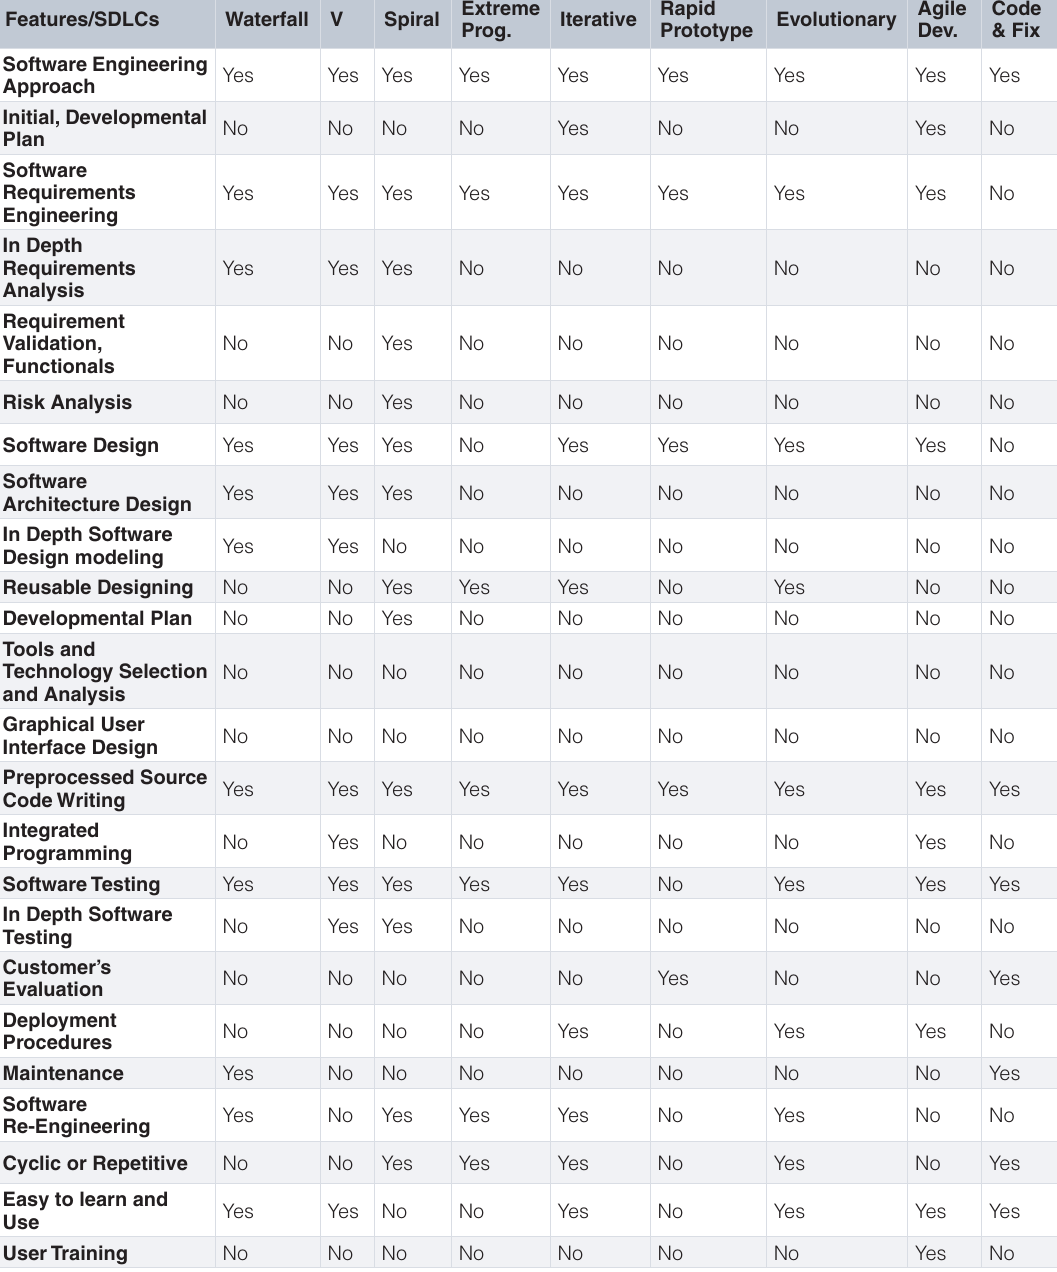
Table 1. Comparative feature based analysis between different software development life cycle models: Waterfall Model, V-Model, Spiral Model, Iterative and Incremental Model, Rapid Prototype Model, Extreme Programming Model, Evolutionary Model, Agile Development Model, Code and Fix Model . Extreme Waterfall V Spiral